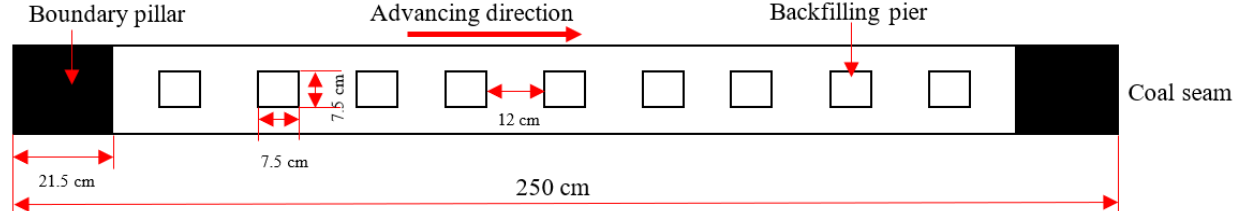
Figure 7. Schematic diagram of backfilling in the physical model.